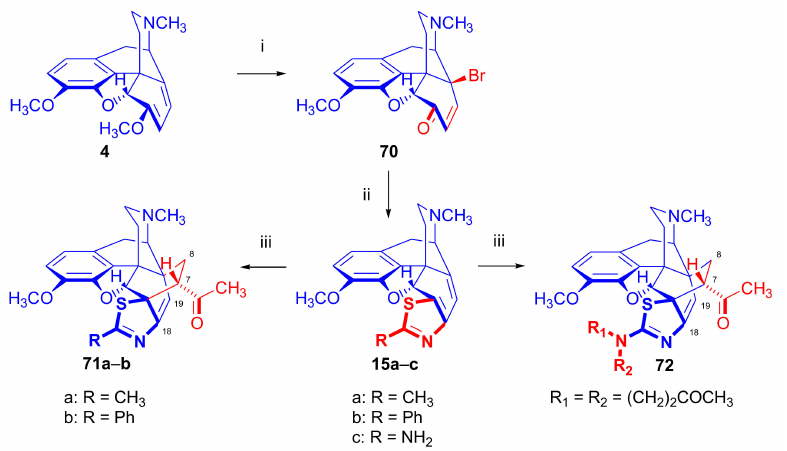
Figure 22. Synthesis of C-ring-fused thiazolothevinone analogues. Reagents and conditions : (i): N - bromosuccinimide, acetone–water 2:1 ( v/v ); (ii): RCSNH 2 , DMF, reflux, 30 min, 27–63%; and (iii): methyl vinyl ketone, 100 ◦ C, 4 h,